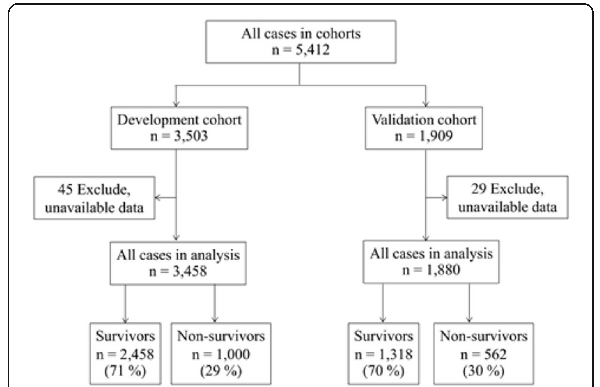
Fig. 1 (abstract P5). Flow chart of subject disposition for the THAI-ICU Score study, randomly into development cohort and validation cohort